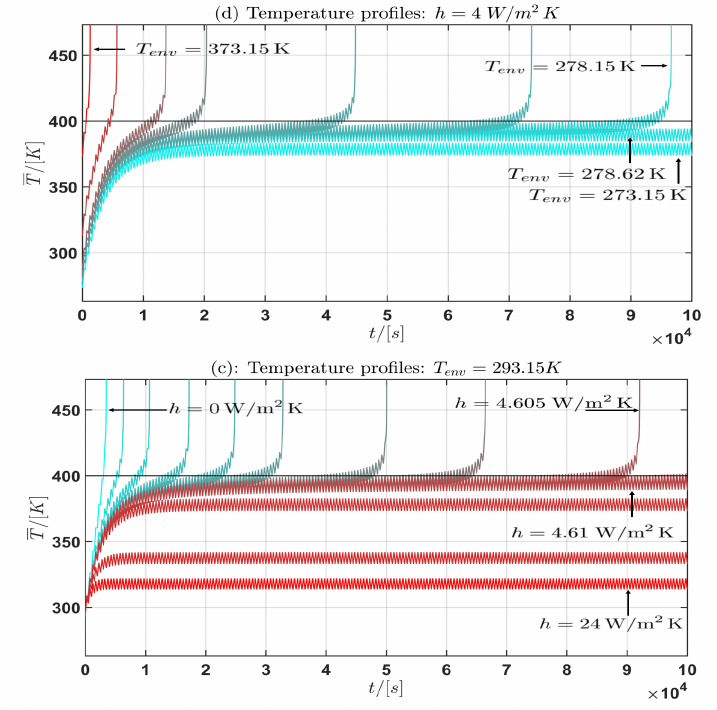
Figure 7. Profile (I) : Temperature profile for the mean cell temperature T : ( a ) T env fixed, h varied; ( b ) h fixed, T env